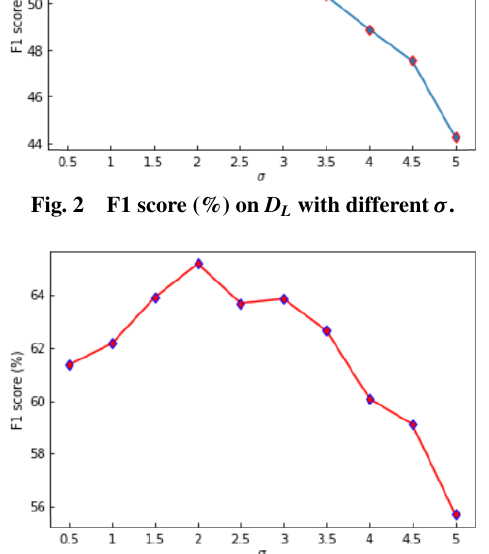
Fig. 3 F1 score (%) on D R with different (cid:27)(cid:27)(cid:27)